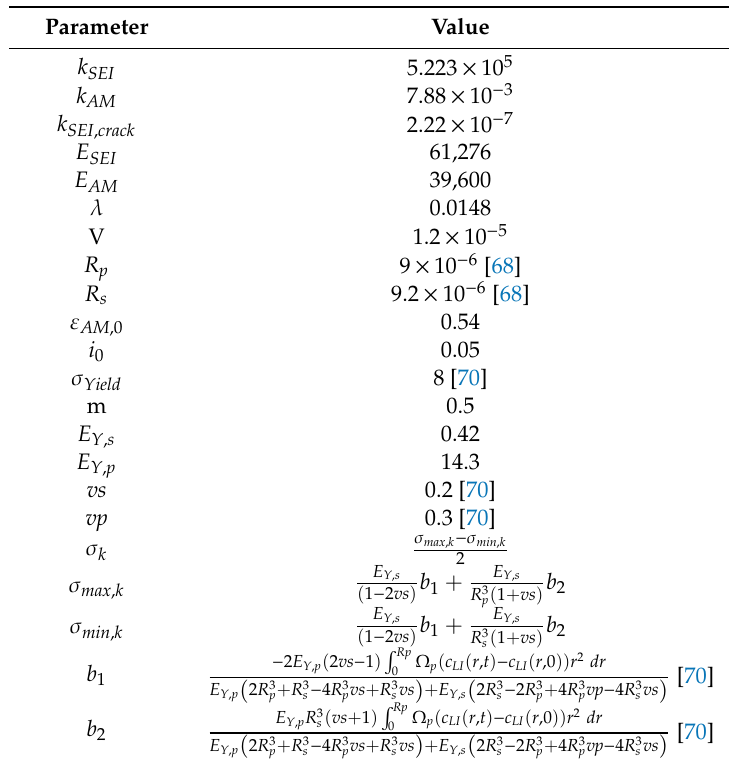
Table A2. Degradation Model